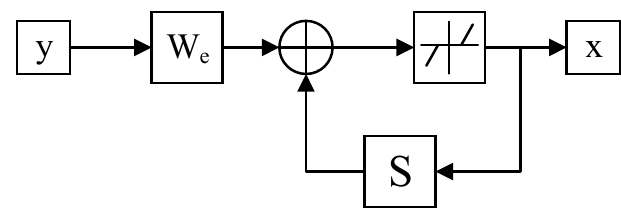
Figure 1. Scheme of the iteration with iterative shrinkage-thresholding algorithm (ISTA).